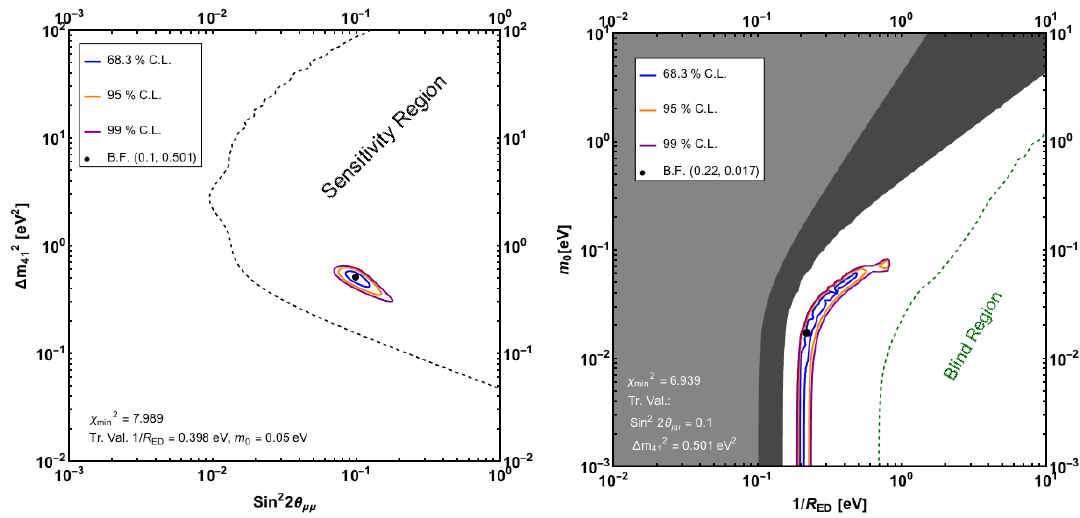
Figure 6 . Left panel, sensitivity results (cid:12)tting the 3+1 model parameters assuming the ‘true’ LED parameters m 0 = 0 : 05 eV and 1 =R ED = 0 : 398 eV, for normal ordering. Right panel, sensitivity results (cid:12)tting the LED parameters for the ‘true’ 3+1 parameters sin 2 2 (cid:18) (cid:22)(cid:22) = 0 : 1 and (cid:1) m 2 0 : 5 eV 2 , also for normal ordering. The allowed sensitivity regions correspond to the 68 : 3% of C.L. (blue), 95% of C.L. (orange) and 99% of C.L. (purple), the best-(cid:12)t points appear as black